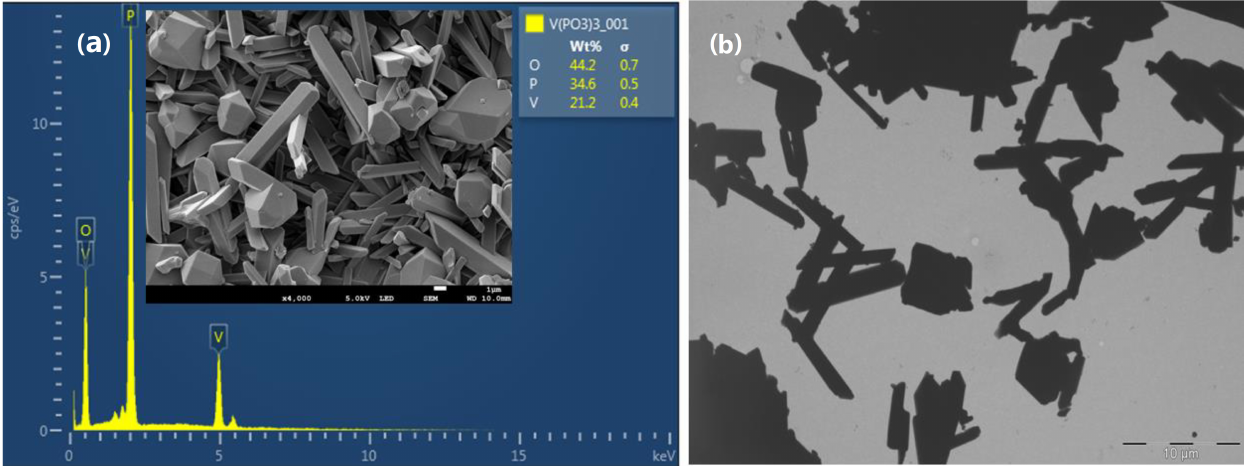
Figure 2. ( a ) SEM-EDX results and ( b ) TEM graphical images of the vanadium precipitate obtained from fusing ammonium phosphate with vanadium oxide (V 2 O 5